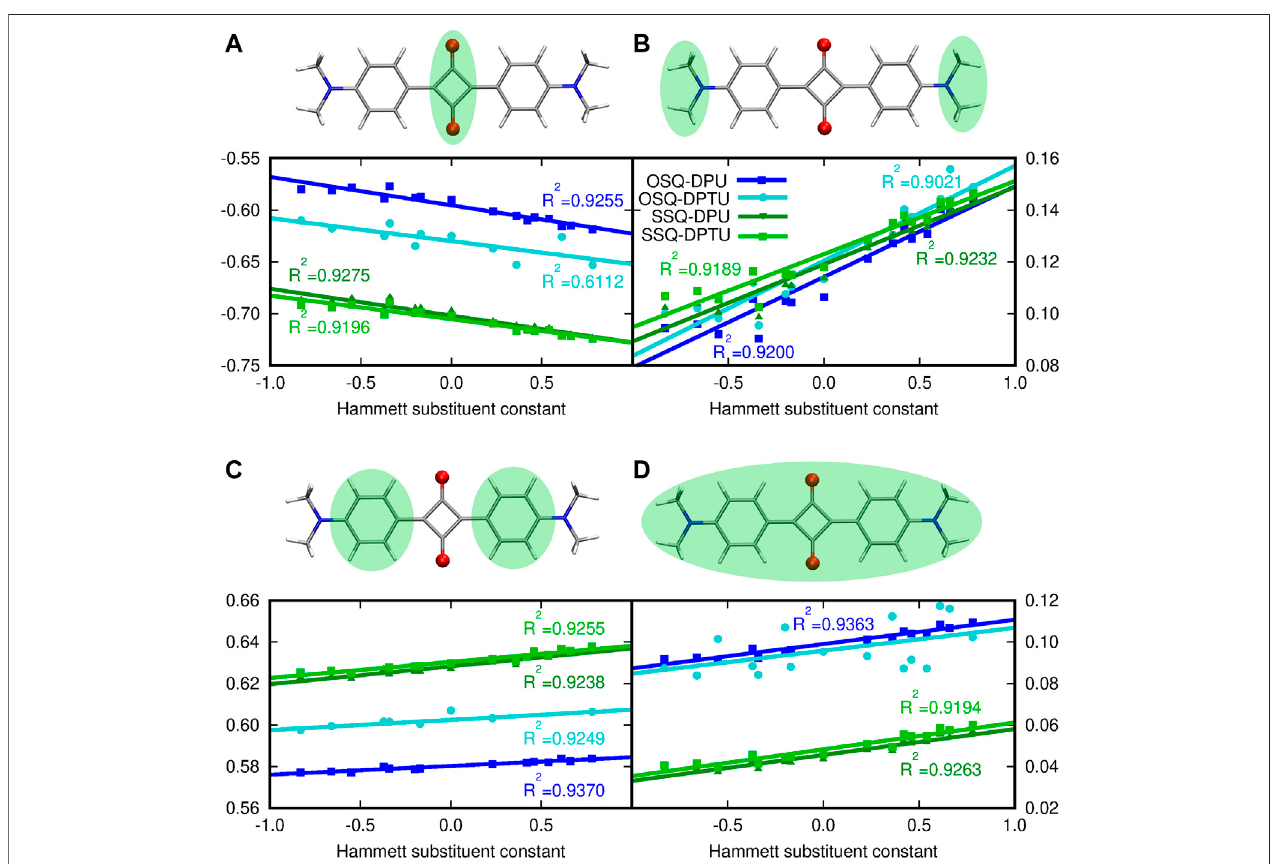
FIGURE 5 | Modi fi cation of the NPA partial charge distribution in the central (thio)squaraine unit upon substitution in N,N ′ -diphenyl(thio)urea fragments: (A) in the central squaric ring, (B) in the terminal N,N-dimethylamino groups, (C) in phenyl rings, and (D) in the whole (thio)squaraine moiety. Sum of partial charges from the considered fragment, presented in the green background, is given as an ordinate.